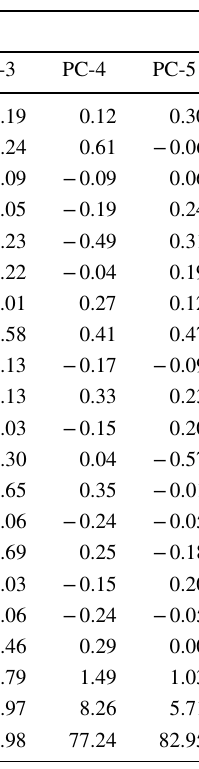
Values in bold indicates significant